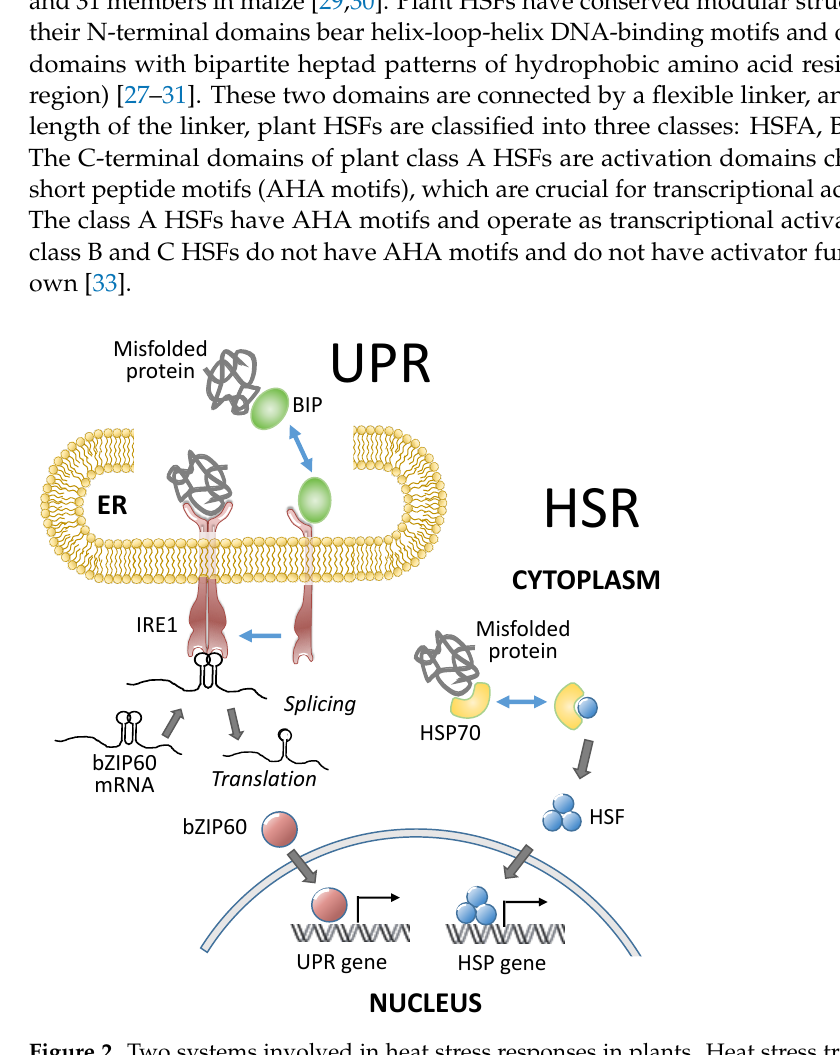
Figure 2. Two systems involved in heat stress responses in plants. Heat stress triggers protective mechanisms collectively called heat stress responses (HSRs). Both HSR in the cytoplasm and unfolded protein responses (UPR) in the endoplasmic reticulum (ER) mitigate the damage from heat stress and protect plants from further stress. The UPR and HSR occur in different cellular compartments, but both responses are elicited by misfolded proteins that accumulate in the ER and cytoplasm, respectively. The HSP and UPR genes in plants are upregulated by the activation of stress-transducing transcription factors, such as bZIP60 (basic leucine zipper 60) in the UPR and HSFs in the HSR. IRE1, a key factor in the UPR, is a dual protein kinase and ribonuclease involved in the splicing of bZIP60 mRNA. HSR, heat stress response; UPR, unfolded protein response; ER, endoplasmic reticulum; bZIP60, basic leucine zipper 60; HSP, heat shock protein; HSF, heat shock transcription factor; HSP70, heat shock protein 70; BIP, binding immunoglobulin protein; and IRE1, inositol-requiring enzyme